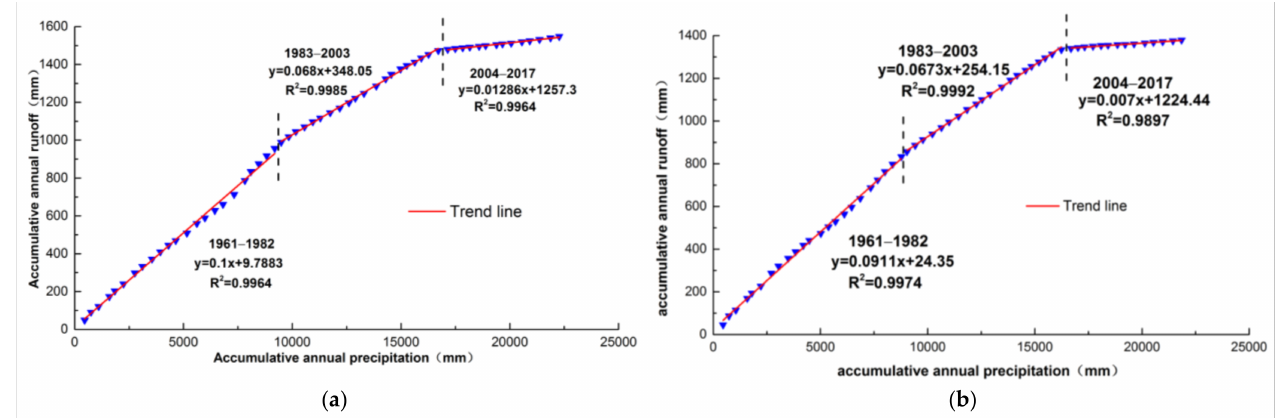
Figure 5. Double mass curve of the annual precipitation and runoff for: ( a ) Yanghe River Basin and ( b ) Sanggan River Basin during the period